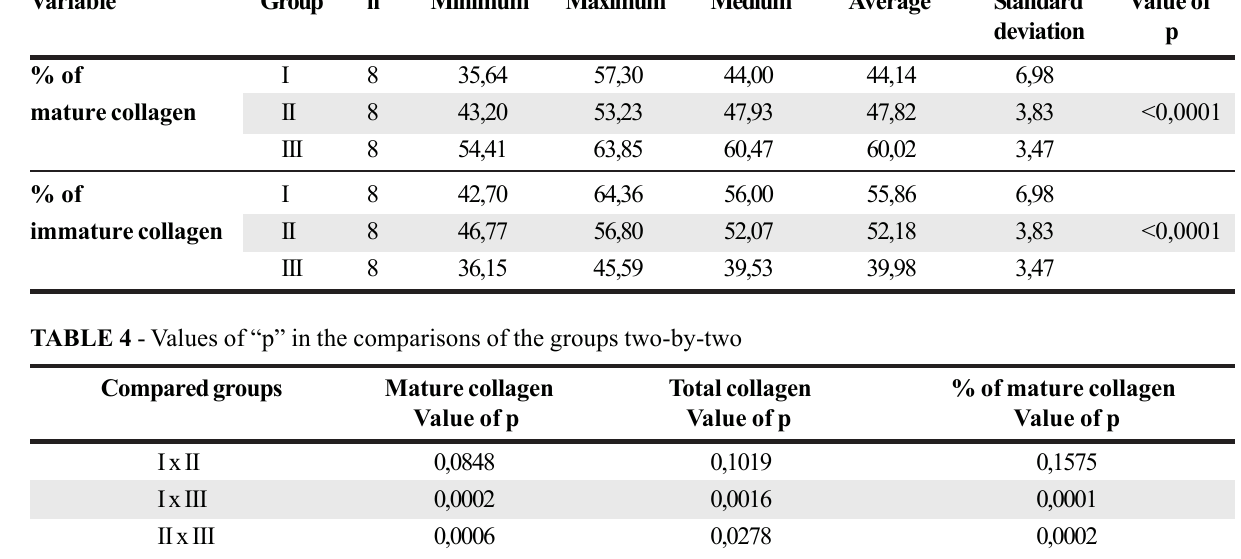
TABLE 3 - Percentage of mature and immature collagen in the three groups Variable